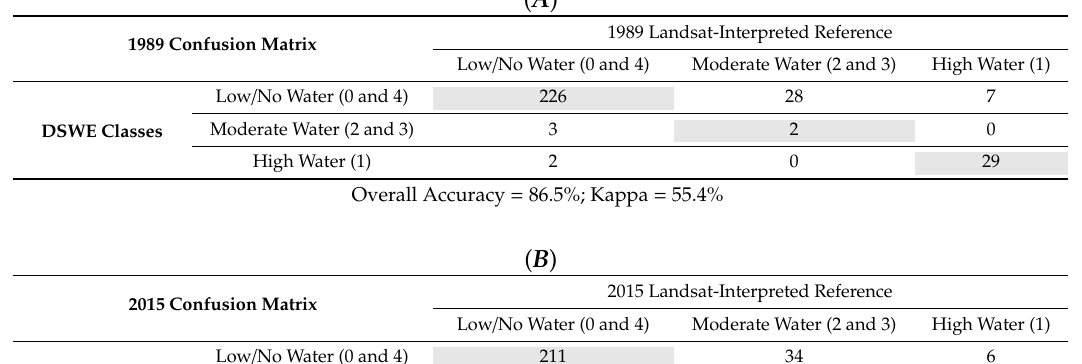
Table 2. Confusion matrices for 1989 (A), 2015 (B), and 2018